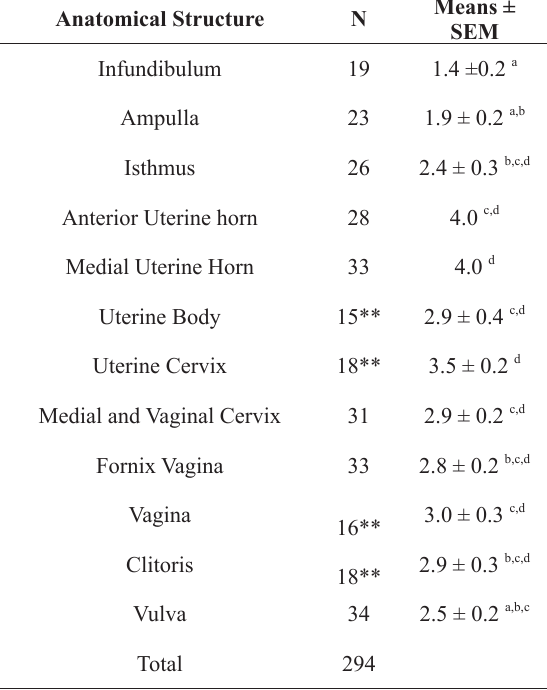
Distribution of microscopic lesions in the uterine tube (infundibulum, ampola andisthmus), cervix (uterine, medial and vaginal), vagina and vulva of heifers with GVS and presenting positive culture for Ureaplasma